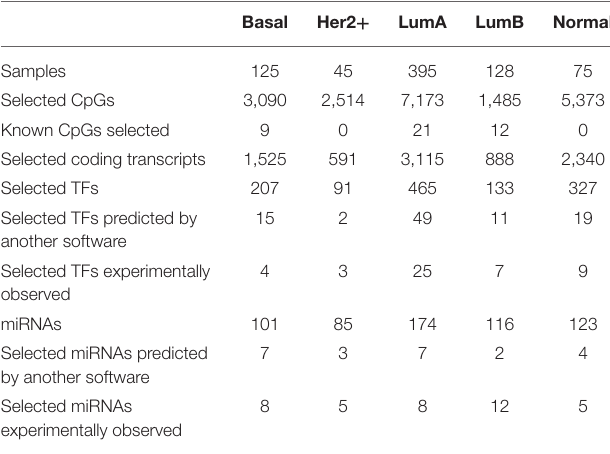
TABLE 1 | Size of input and output of the models per subtype: Basal, Her2 + , Luminal A, Luminal B as well as normal (i.e. tumor-adjacent healthy tissue).